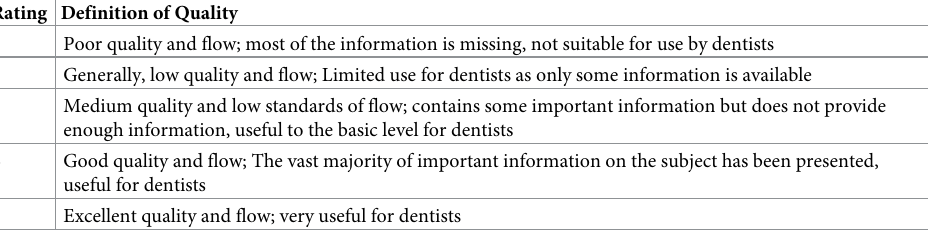
Table 2. Modified Global Quality Score (mGQS) scoring system.